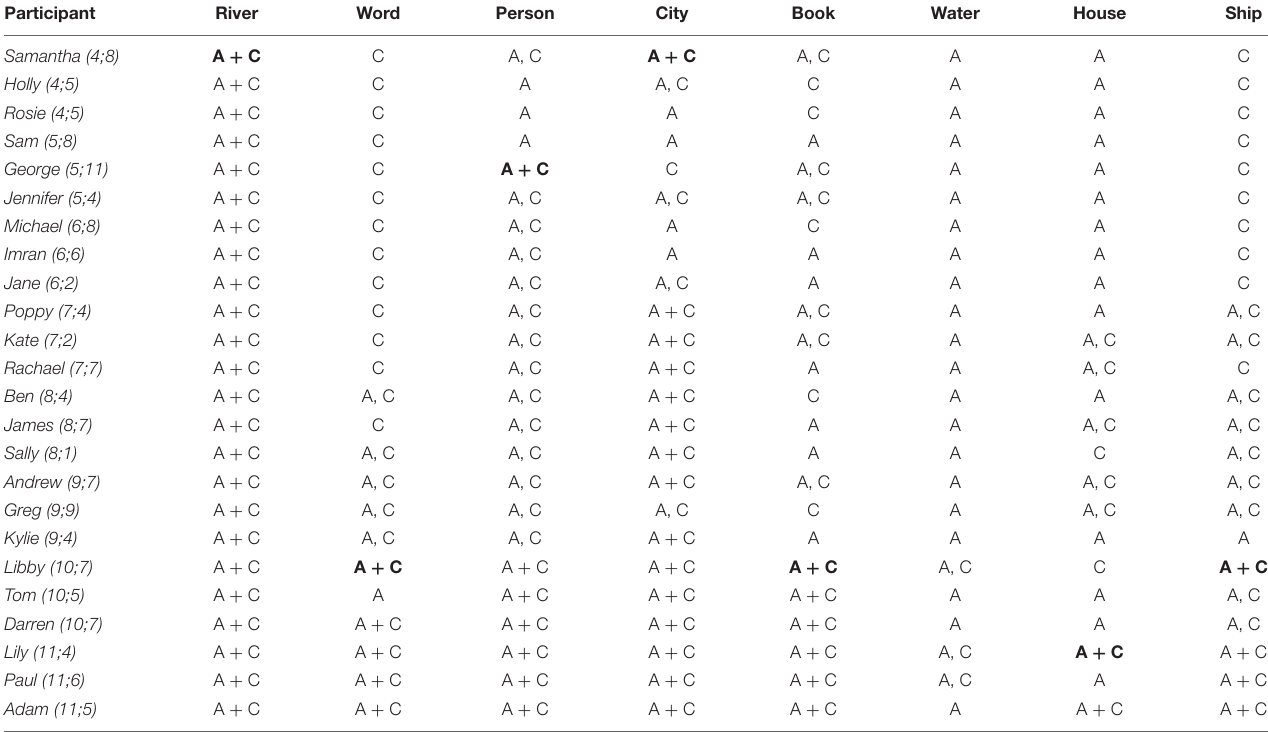
TABLE 2 | Coding the responses of the 24 children. Participant River Word Person City Book Water House